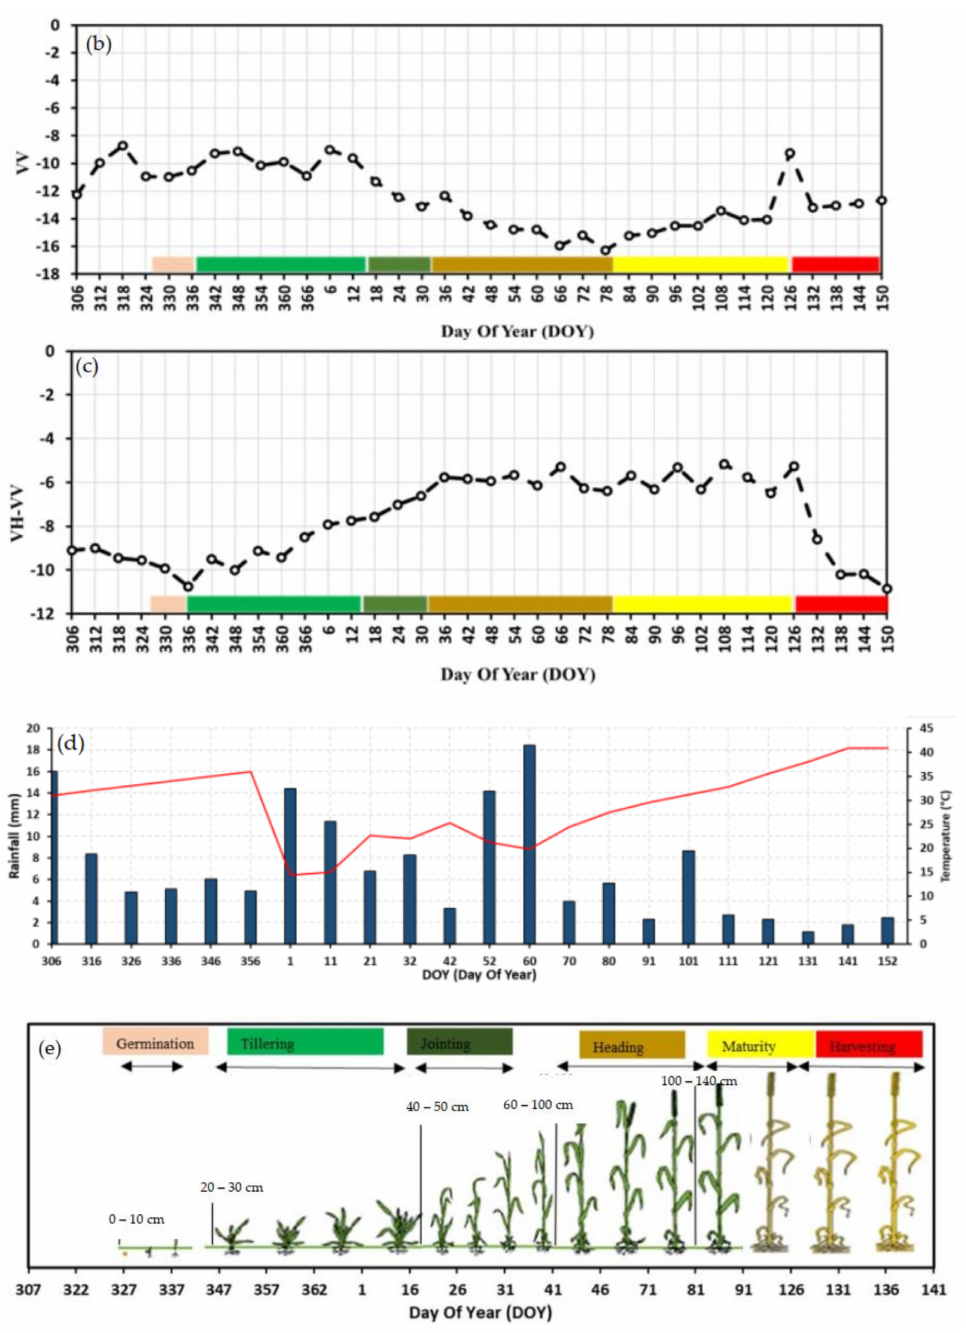
Figure 7. Mean of the Sentinel-1 backscattering coefficients at VH ( a ), VV ( b ), VH–VV ( c ) polarizations, ( d ) the ombrothermal diagram of climatic conditions in the TIP, ( e ) main crop phenological stages survey for wheat plots and measured height of wheat